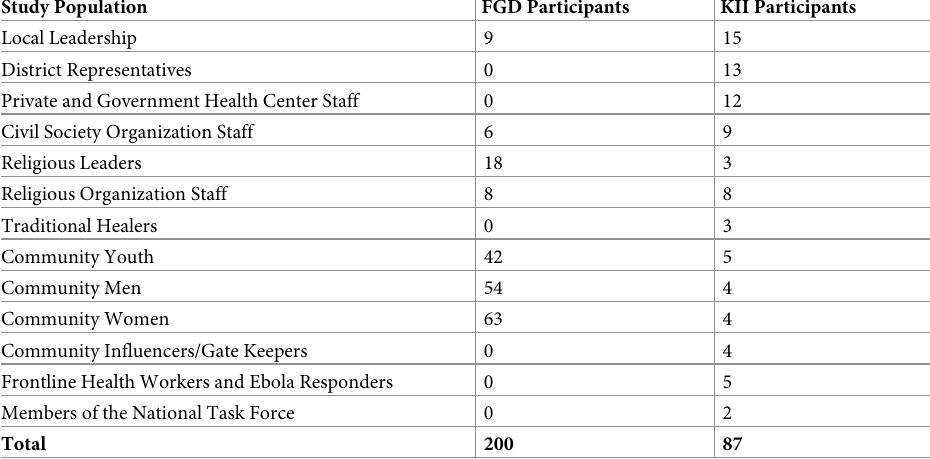
Table 2. Study population by participant